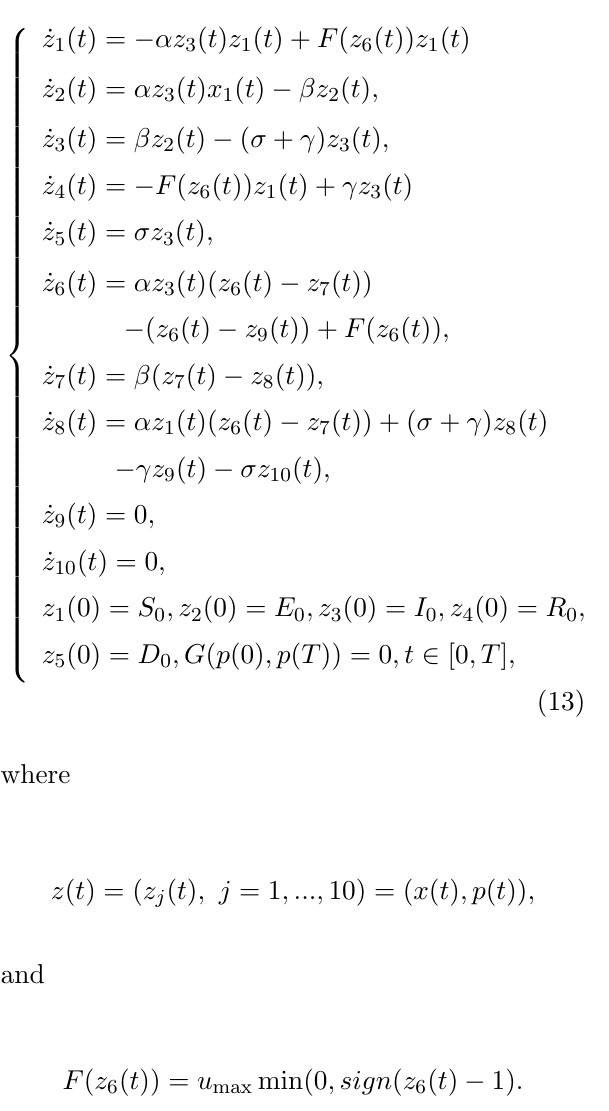
After 150 days, in the absence of an effective vac- cine, the number of susceptible individuals does not almost decrease, the number of deaths in- creases. The number of susceptible individuals as well as the number of exposed to the virus in- creases considerably(see Figure 3). The execution time of the shooting method is CP U time equals 3 . 18 s